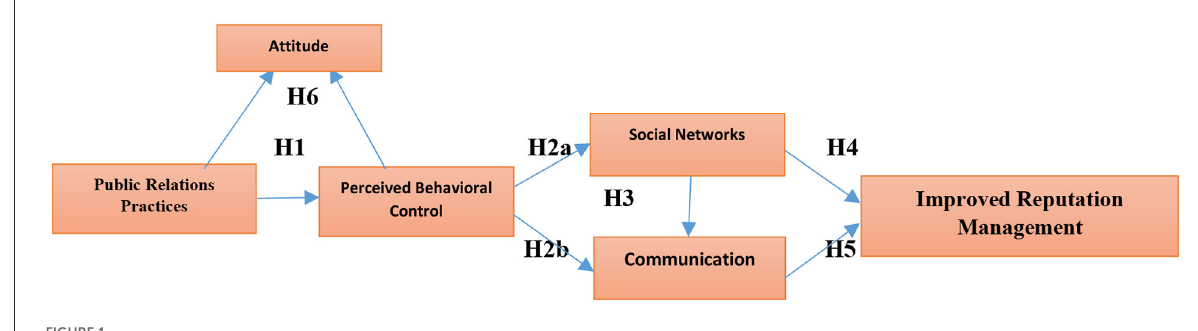
FIGURE1 Conceptual model of current research.